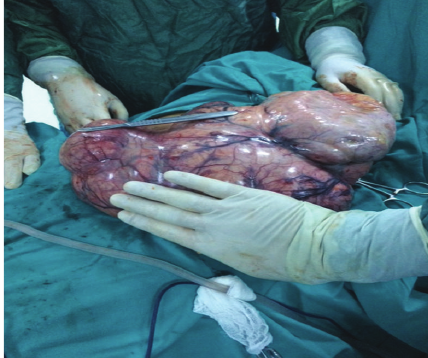
Figure 3: The figure shows intra-abdominal view of multilobulated white-yellowish coloured mass with size of 30 × 23 × 12 cm and 5.4 kg.